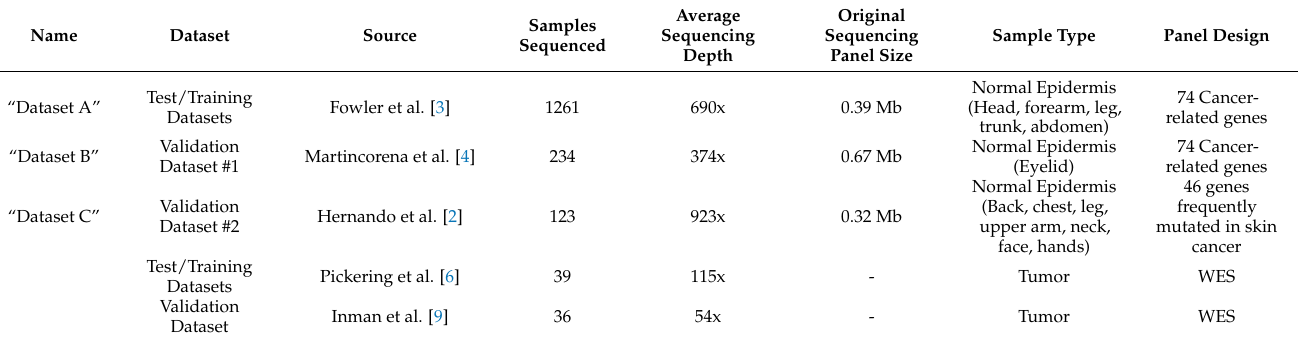
Table 1. Summary of human clinically-normal epidermis and cSCC mutation